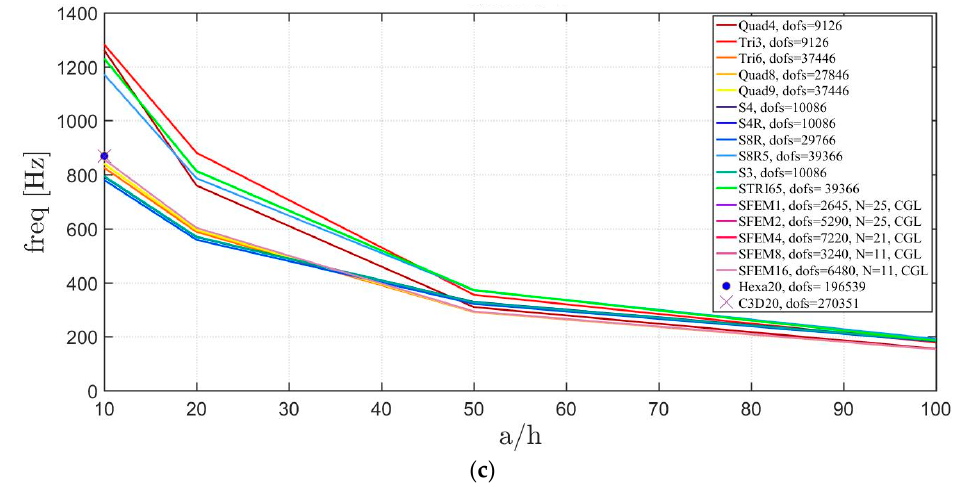
Figure 16. Thickness effect on the first three natural frequencies of a skew plate with a not-symmetric lamination scheme: ( a ) First frequency; ( b ) Second frequency; ( c ) Third frequency.